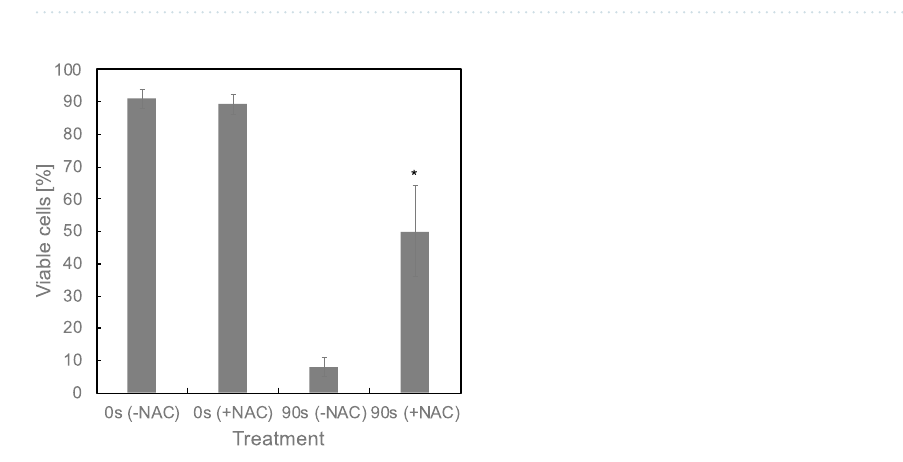
Figure 8. Detection of extracellular H 2 O 2 , NO 2 at 1 h and 24 h. H 2 O 2 concentrations in ( a ) Jurkat and ( b ) U937 cell culture media were measured following plasma treatment for 0, 60 and 90 s respectively. The concentrations of NO culture media were measured at 1 h and 24 h following plasma treatment. All data represent mean concentration ± SD, n = 3. Student’s t-test was preformed comparing plasma treated samples vs untreated control and the significance is indicated as * p < 0.05 .